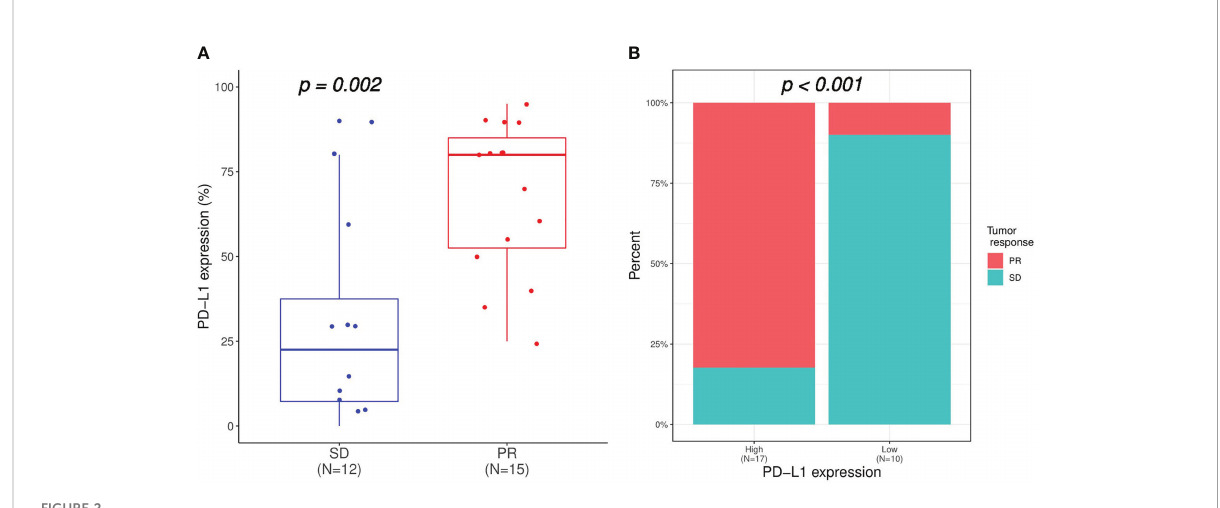
FIGURE 2 Relation of PD-L1 expression with immunotherapy response. (A) Comparison of PD-L1 expression between patients achieved SD and PR. (B) Comparison of immunotherapy response between patients with high (TPS ≥ 30%) and low (TPS <30%) PD-L1 expression. SD, stable disease; PR, partial response; TPS, tumor proportion